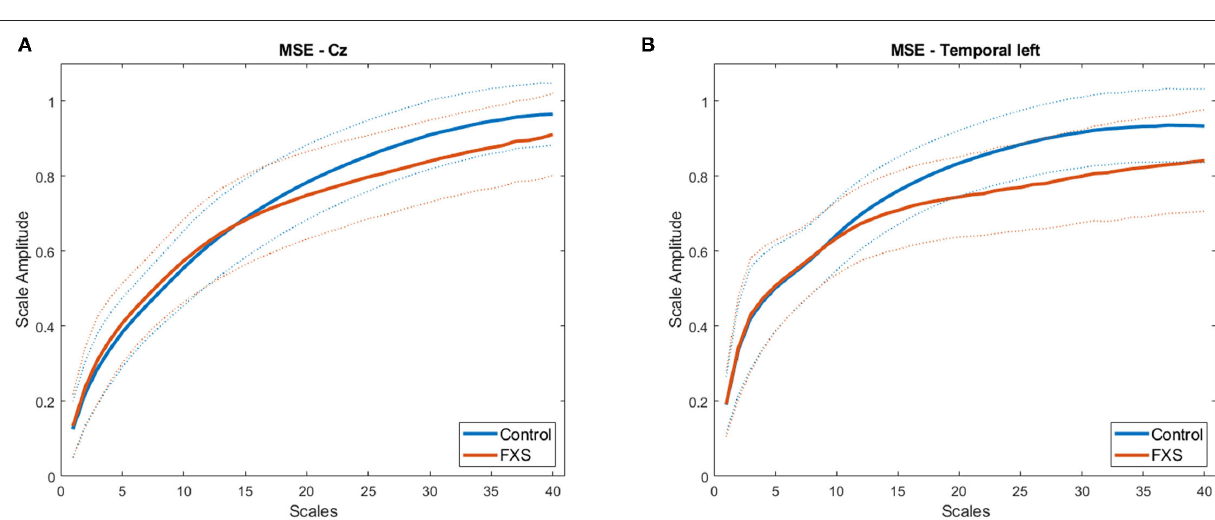
FIGURE 7 | Average MSE time scales for FXS (red) and controls (blue) in regions of interest Cz (A) and TL (B) . Dotted lines indicate SD for each